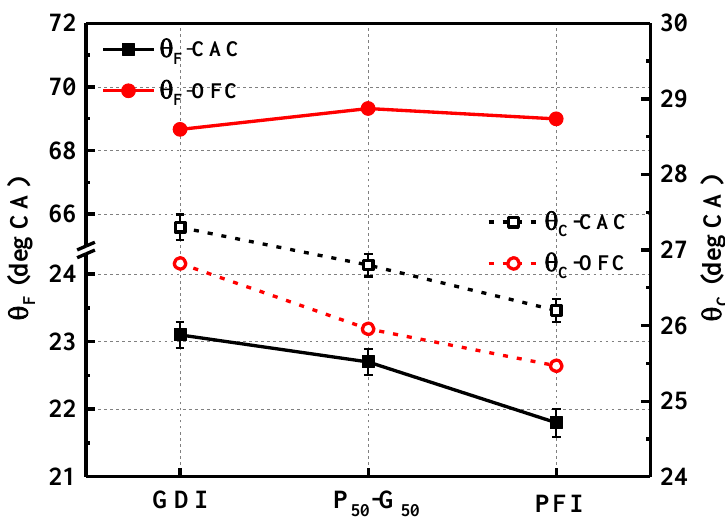
Figure 9. Comparison of 𝜃 𝐹 and 𝜃 𝐶 between CAC and OFC.